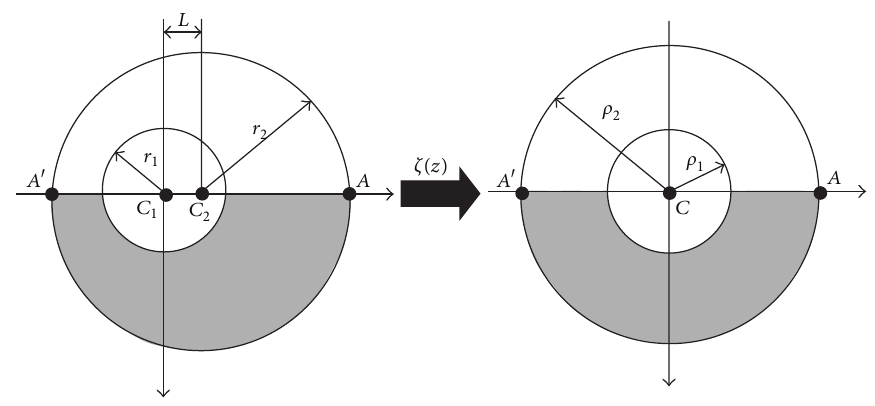
Figure 1: Problem